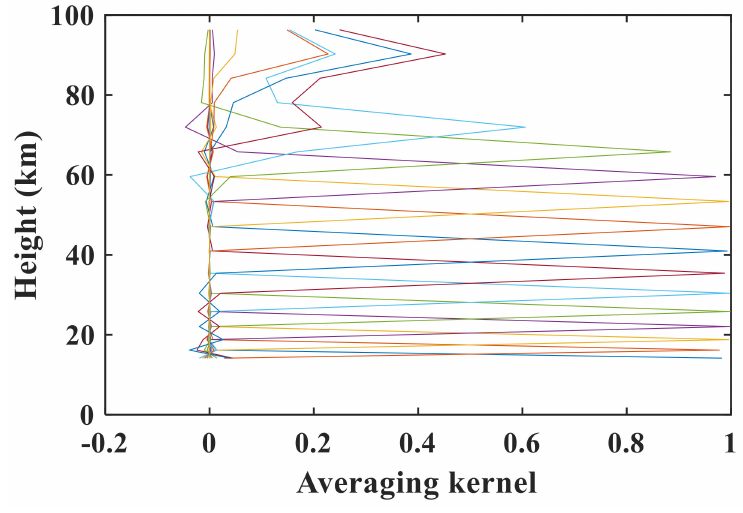
Figure 11. N 2 O averaging kernel for sunrise measurement 48359. Table 2. RMSE and DOFs for N 2 O, NO 2 , and HF retrieval